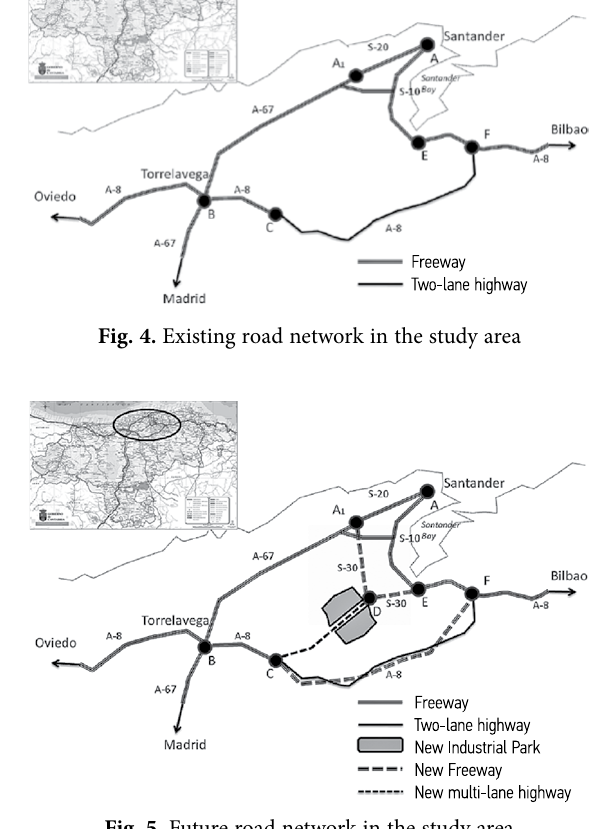
Fig. 5. Future road network in the study area